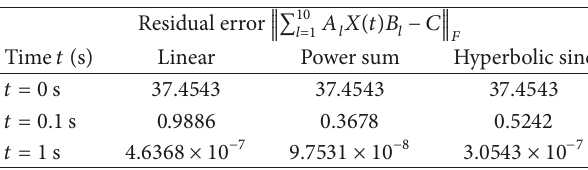
Table1:Performanceofthegeneralrecurrentneuralnetworkmodel (2) with three different activation functions (linear, power sum, and hyperbolic sine) for solving GLME